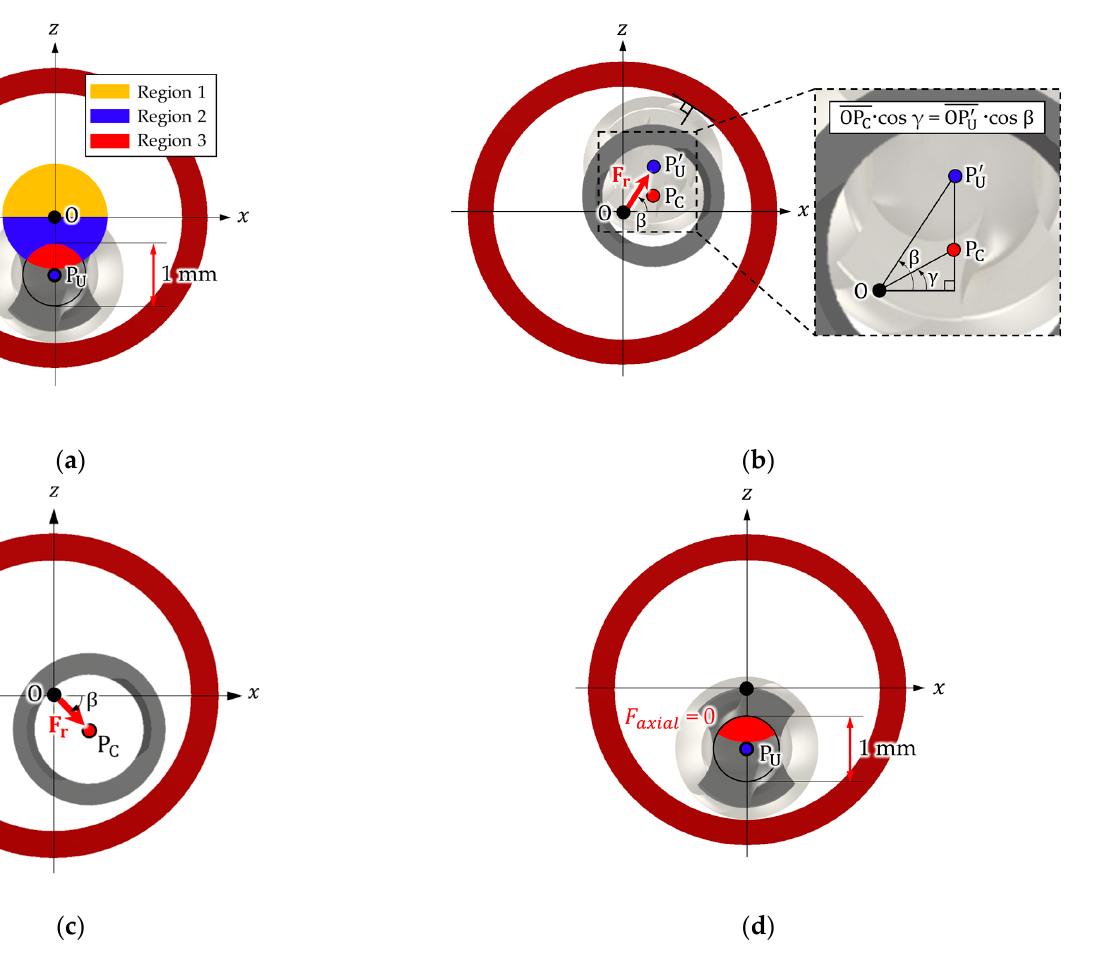
Figure 7. ( a ) Possible region of the center of the connecting part of the delivery catheter; ( b ) direction of F r and β in region 1; ( c ) direction of F r and β in region 2; ( d ) F r in region 3. Region 1 in Figure 7a is a region in which the Z coordinate of P C is positive, and